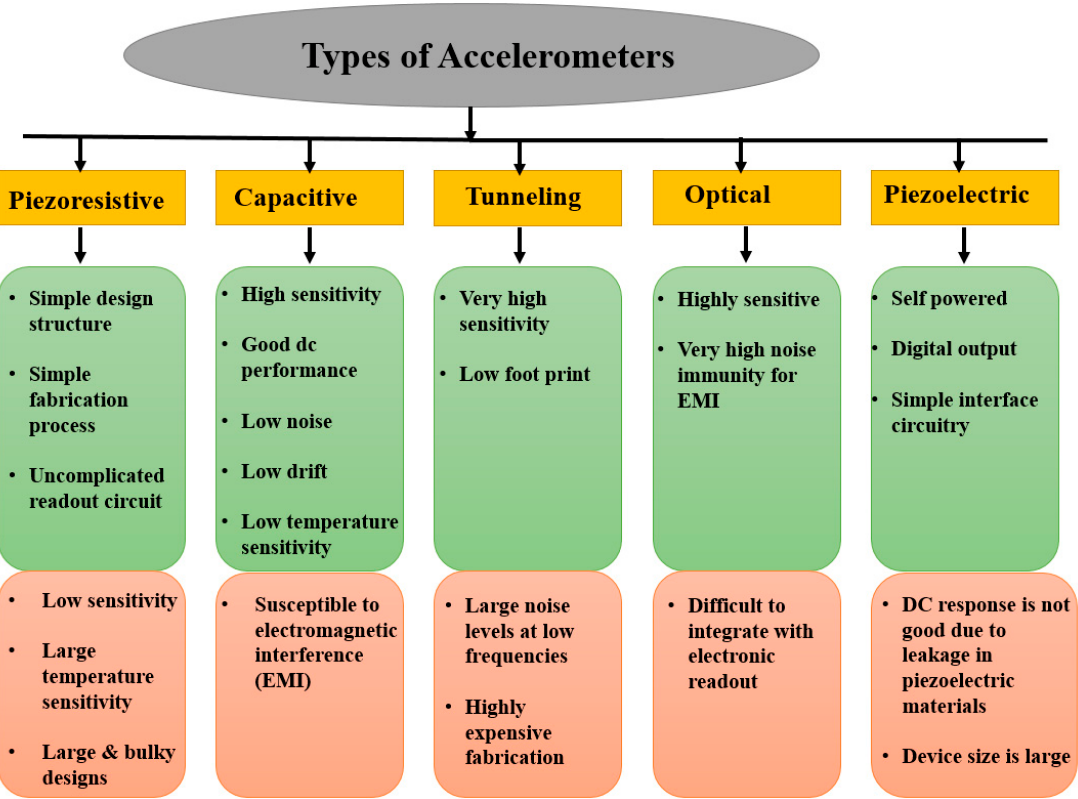
Figure 2. Advantages and disadvantages of various transduction schemes.